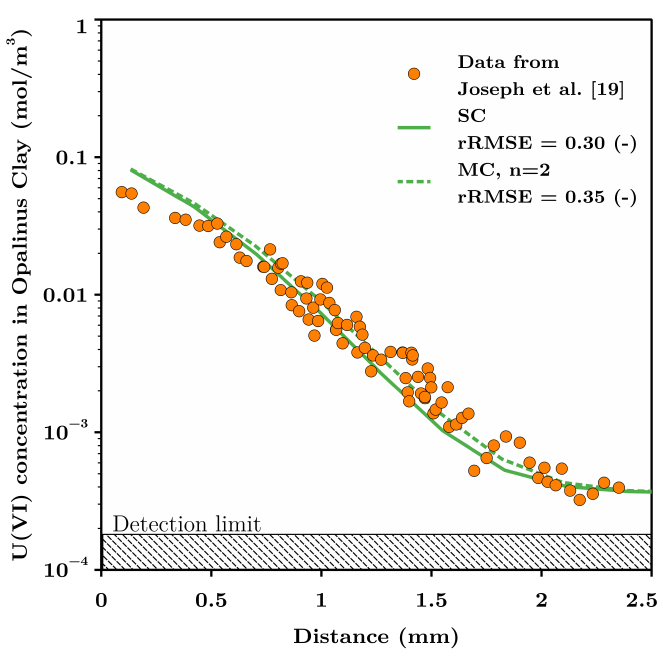
Figure 5. The model is validated for uranium sorption and diffusion. SC (solid line) as well as MC (dashed line, n = 2) simulation results coincide with the laboratory data (dots) of the diffusion experiment with U(VI) and Opalinus Clay using a mineral composition of 23wt.% kaolinite, 9wt.% illite, 4wt.% illite/smectite mixed